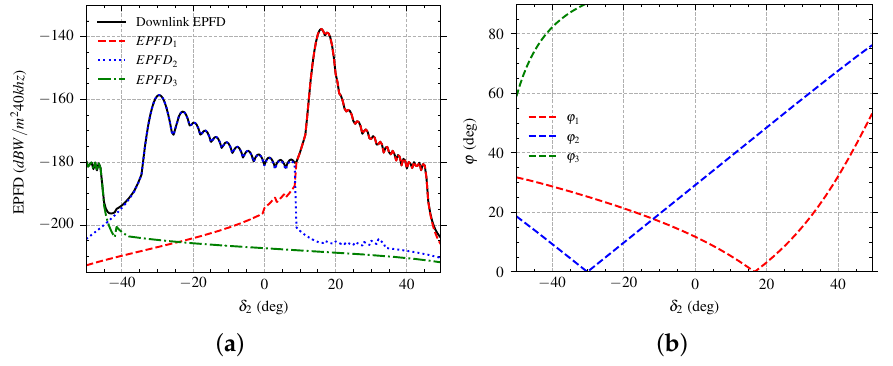
Figure A2. The downlink EPFD and the off-axis angle of the GSO earth station versus the elevation angle α 2 : ( a ) the downlink EPFD with ψ 2 = 25 ◦ ; ( b ) the off-axis angles of GSO earth station with ψ 2 = 25 ◦